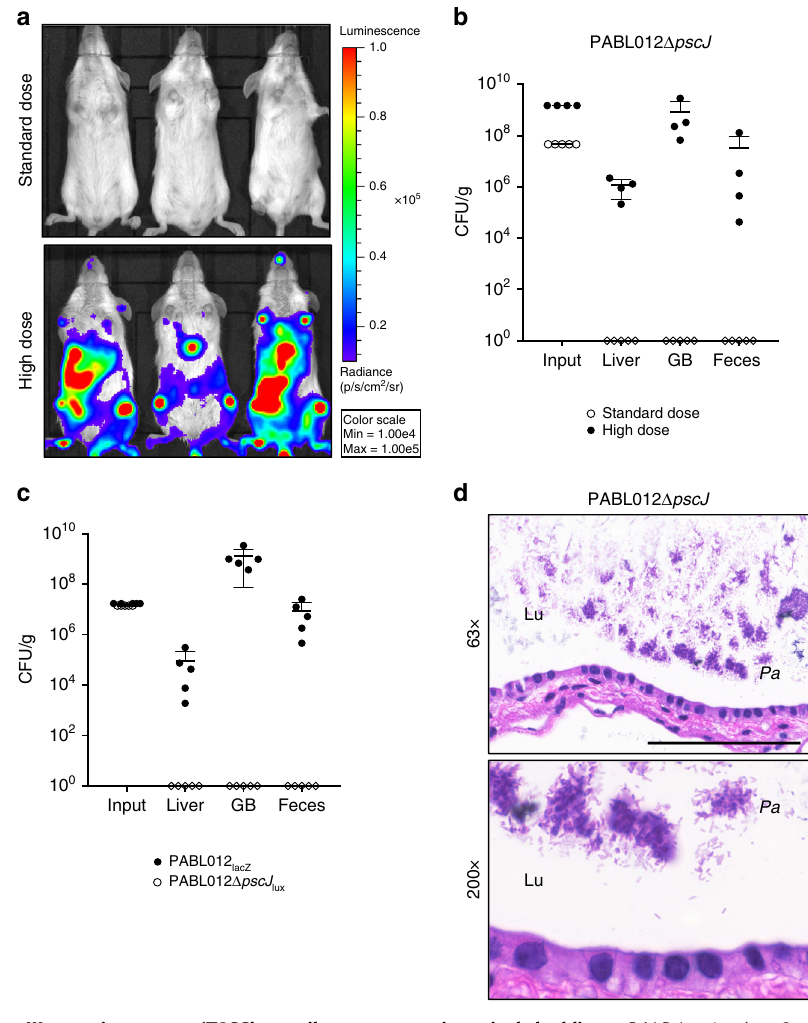
Fig. 5 The P. aeruginosa type III secretion system (T3SS) contributes to gastrointestinal shedding. a BALB/c mice ( n = 3, representative replicate) were infected intravenously with a standard (~2 × 10 6 CFU, open circles) or a high dose (~8 × 10 7 CFU, fi lled circles) of a PABL012 Δ pscJ lux T3SS mutant and imaged at 24 hpi using IVIS. The scale (red = high, blue = low) for all images represents radiance (photons per sec per cm 2 per steradian) with minimum and maximum values normalized to 1 × 10 4 and 1 × 10 5 , respectively. b Mice (standard dose n = 5, open circles; high dose n = 4, black circles) were euthanized, bacteria enumerated from the liver, gallbladder (GB), and feces, and CFU per gram organ reported at 24 hpi. c BALB/c mice ( n = 5) were co- infected intravenously with a 1:1 mix totaling ~2 × 10 6 CFU of PABL012 lacZ ( n = 5, fi lled black circles) and PABL012 Δ pscJ lux ( n = 5, open symbols). Liver, GB, and feces were harvested at 24 hpi for enumeration of viable bacteria. For input 1 g equals 1 mL of wet weight. For scatter plots, each circle or diamond represents data from one mouse. Where no CFU were recovered, data are represented as diamonds on the x -axis. Geometric means (horizontal lines) and SD (whiskers) are shown. d H&E stained sections of gallbladders from mice infected with the high dose of PABL012 Δ pscJ lux . Lu (lumen), Pa ( P. aeruginosa) . Scale bar represents 100 µ M